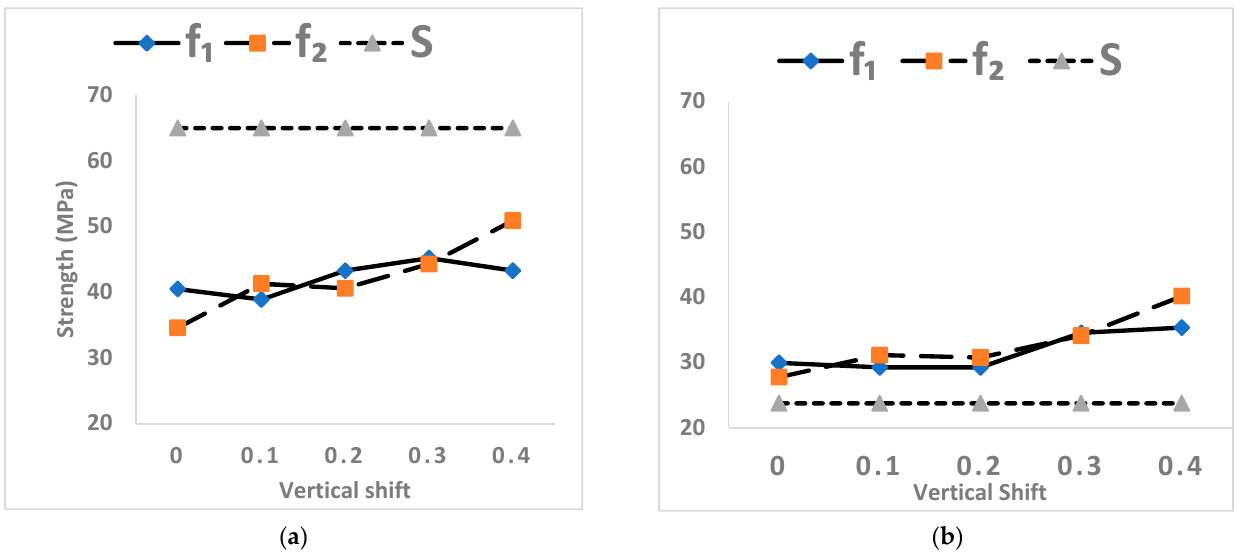
Figure 8. Graphical representation of the relationship between strength versus vertical shift ( a ) with 100% infill density ( b ) with 70% infill density.